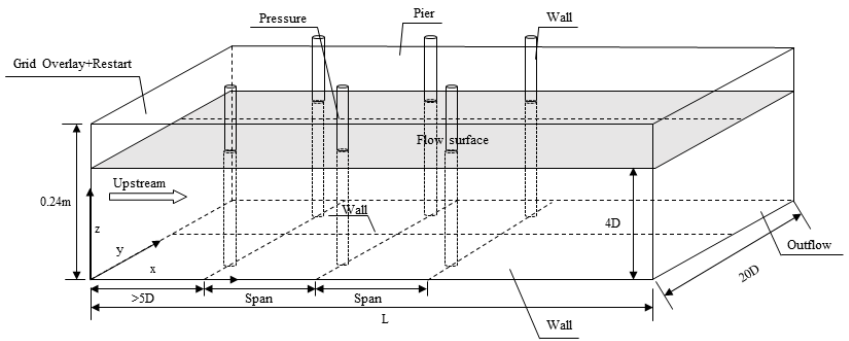
Figure 5. Layout and the boundary conditions of the model with piers.